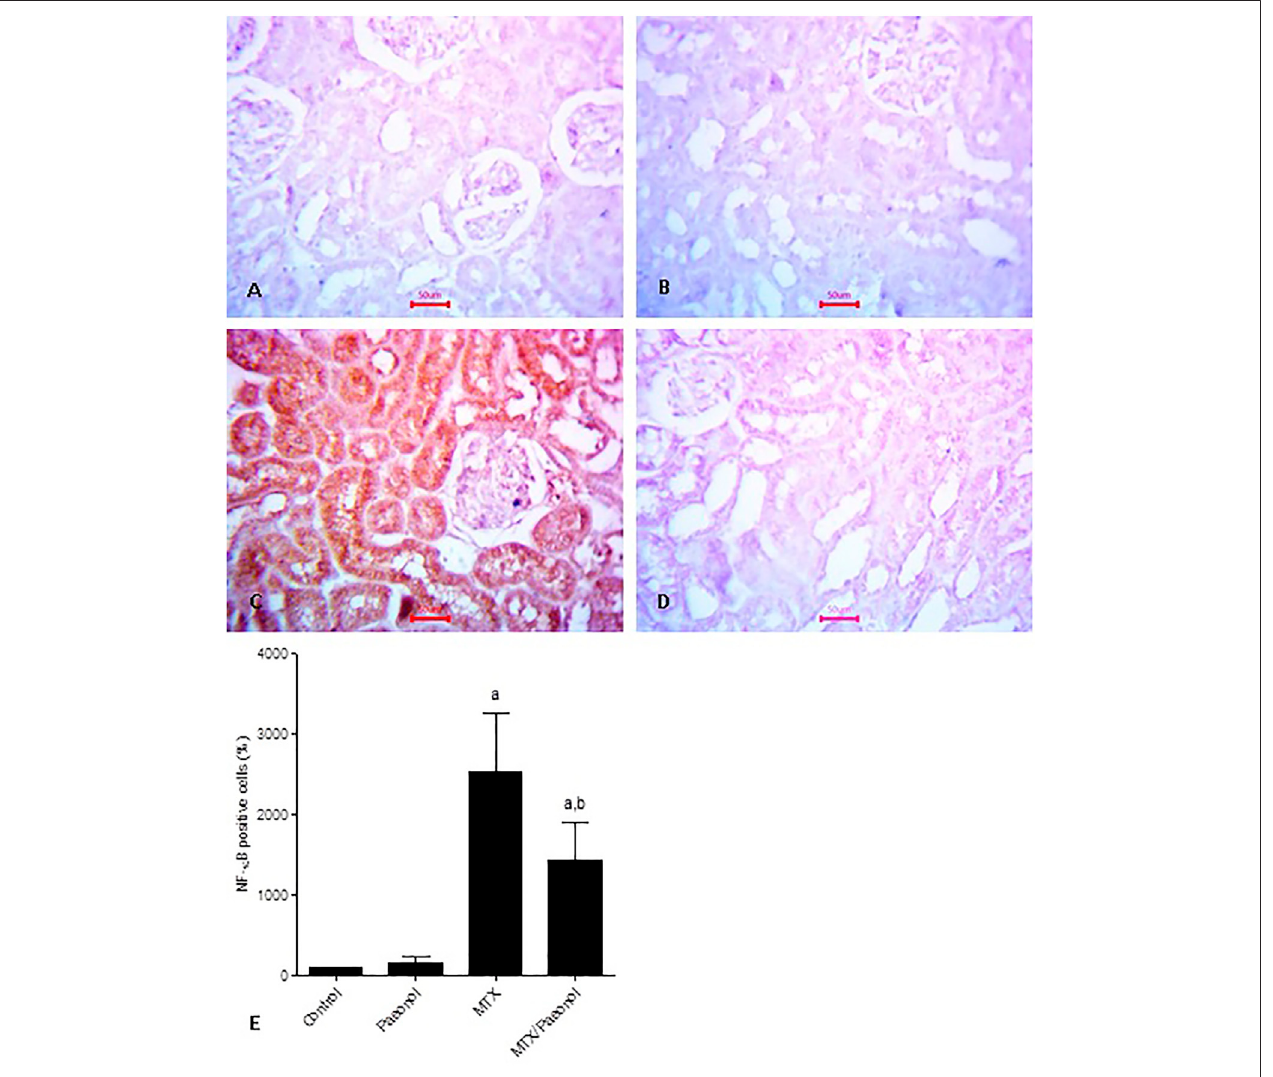
FIGURE 5 | Nuclear factor- κ B (NF- κ B) immunohistochemical staining of the kidney after methotrexate (MTX) and/or paeonol administration. NF- κ B antibody – stainedsectionsoftheratkidney(×400)from (A) control, (B) paeonol-treated, (C) MTX-treated,and (D) MTX/paeonol-treatedrats. (E) Percentofpositivecells comparedtothecontrolgroup,obtainedfromsectionsofeachanimal( n =6foreachgroup),six fi elds/section,whereresultswereconsideredsigni fi cantlydifferentwhen p < .05. a,b Signi fi cant difference compared to control or MTX groups, respectively.